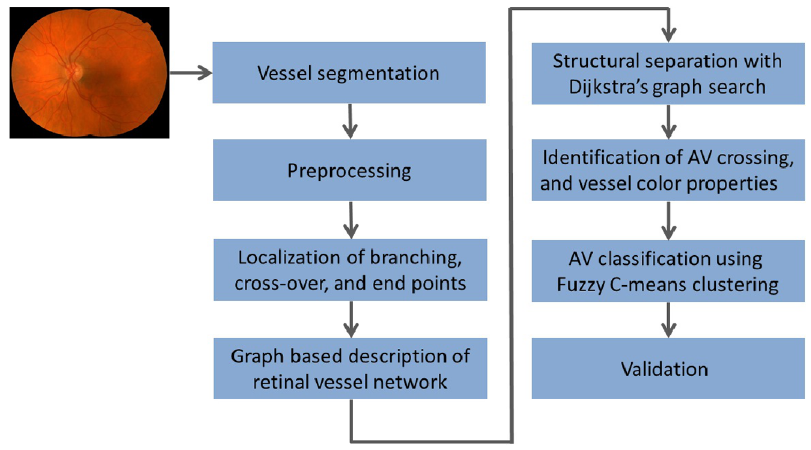
Figure 1. Overview of the steps in proposed method.